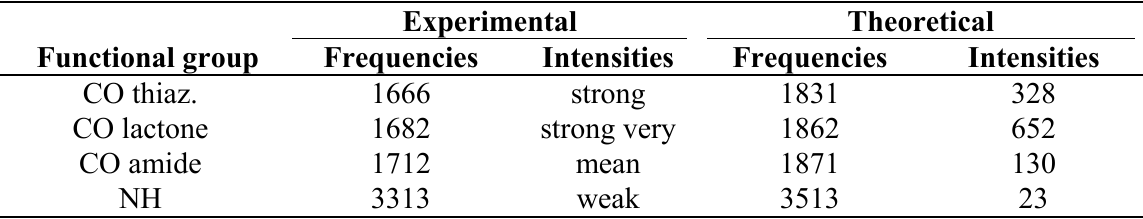
Table 2. Theoretical and experimental vibrational frequencies (cm − 1 ) and theoretical infrared intensities (km mol − 1 ) of 5c